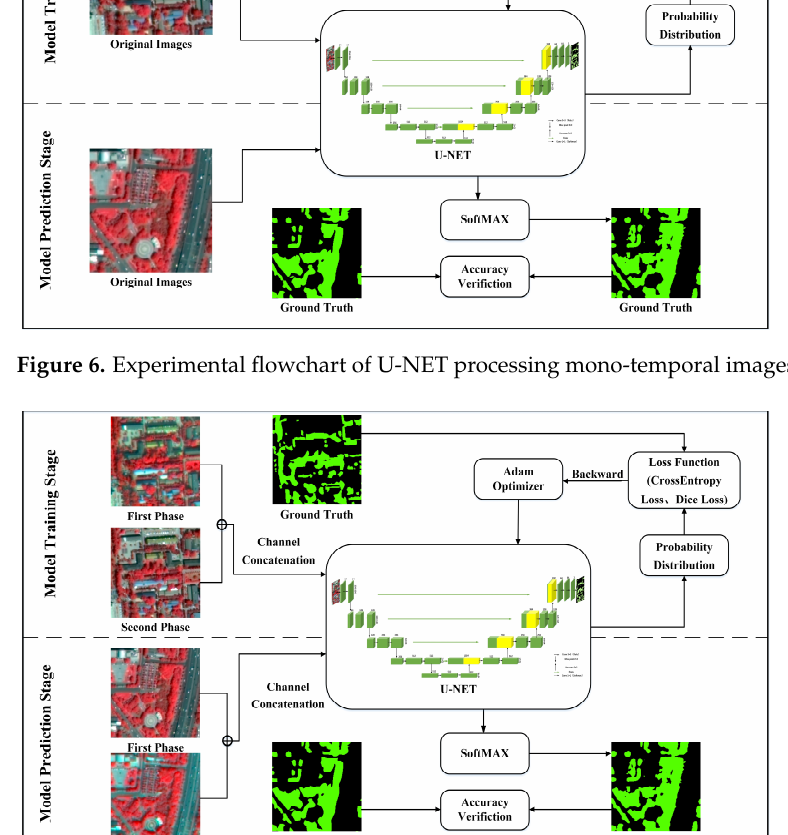
Figure 7. Experimental flowchart of U-NET processing multi-temporal images.